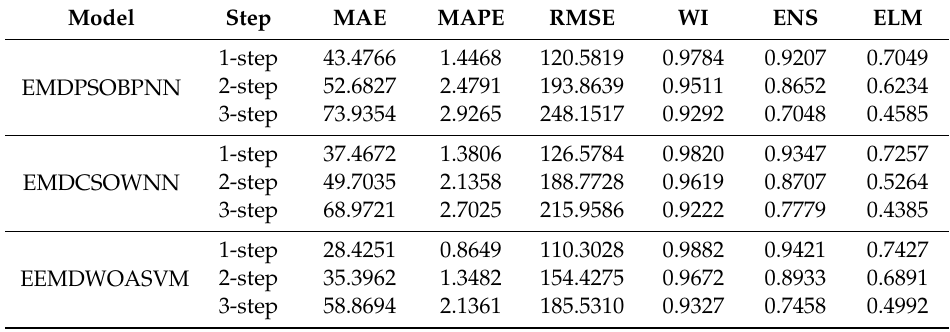
Table 6. Forecasting results of the proposed model and two hybrid models using 30 min electric load data from New South